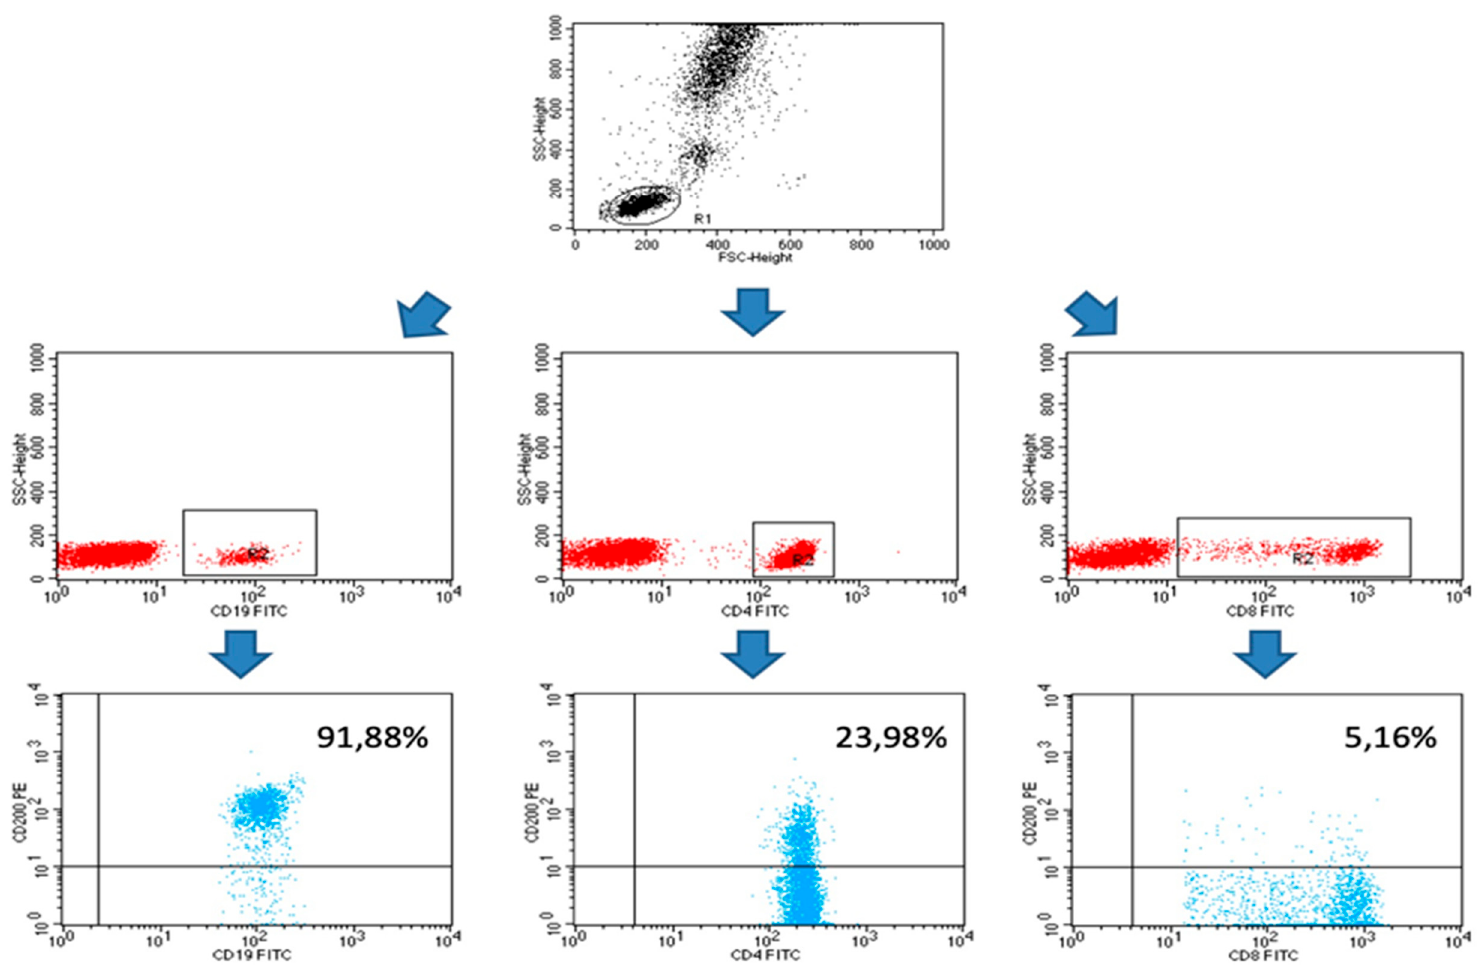
+/ CD8 +/ CD200 T lymphocytes and CD19 +/ CD200 B lymphocytes in EMS Figure A1. Sample analysis of CD4+/CD8+/CD200 T lymphocytes and CD19+/CD200 B lymphocytes in EMS patients. Figure A1. Sample analysis of CD4